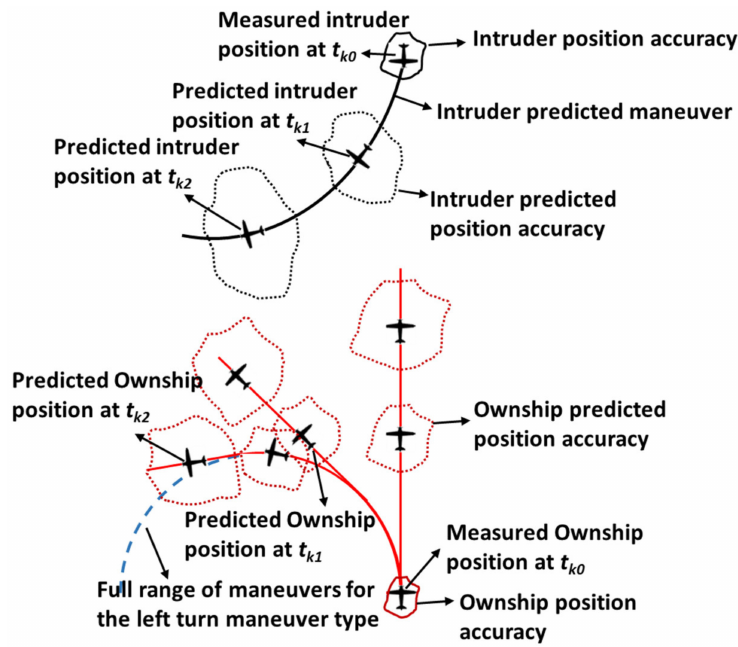
Figure 6. Relative probability function determination for air traffic. Specifically, the RPr is computed approximating the NMAC cylindrical volume with a right parallelogram prism (Figure 7) and assuming that relative position coordinates between ownship and intruder ( P rel , P rel , P rel ) are independent stochastic variables with x y h time-uncorrelated Gaussian distribution.